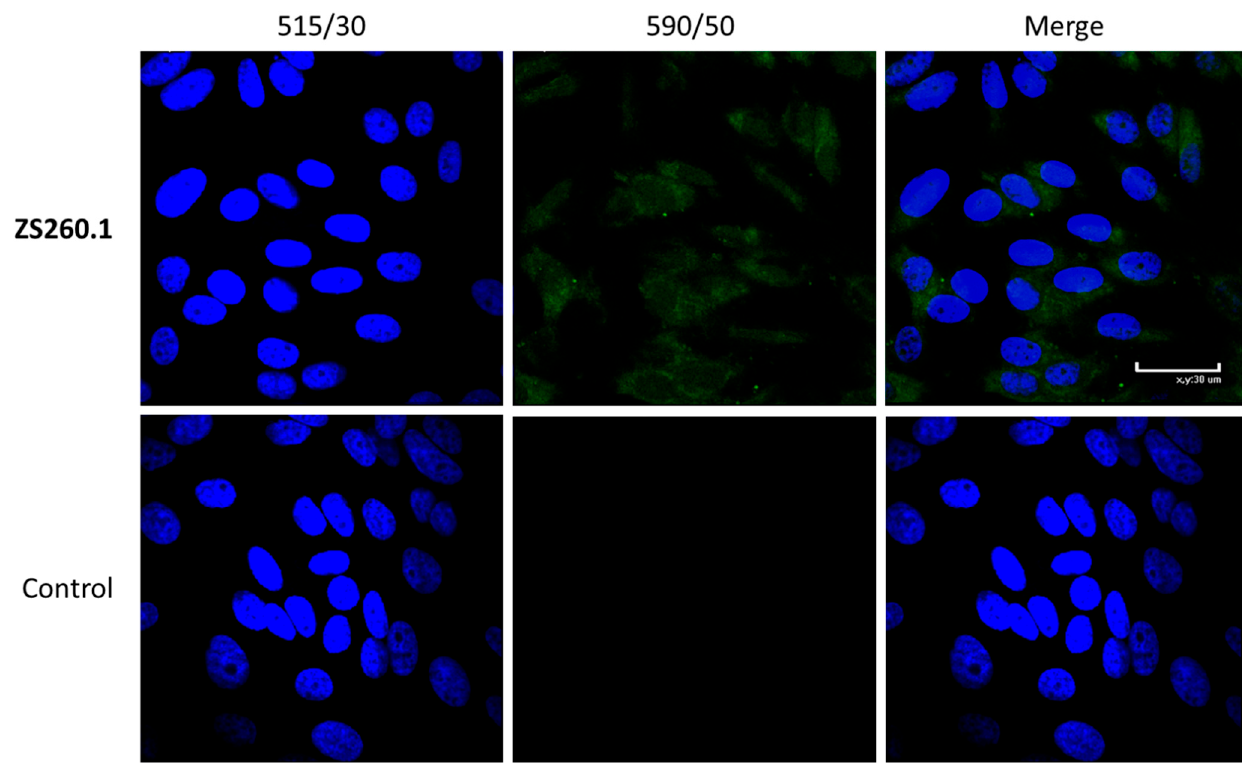
Figure 8. The results of confocal microscopy of the stained cells, treated with ZS260.1 or DMSO as control.